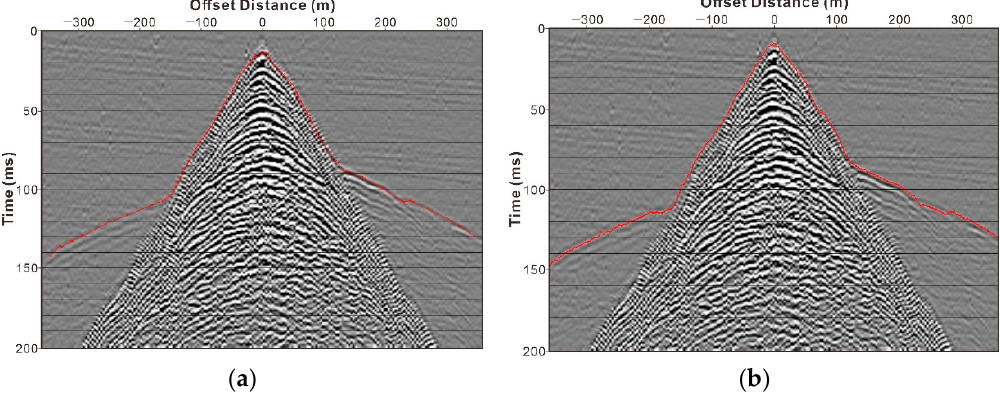
Figure 6. Results of first break picking: ( a ) manual and ( b ) automatic.